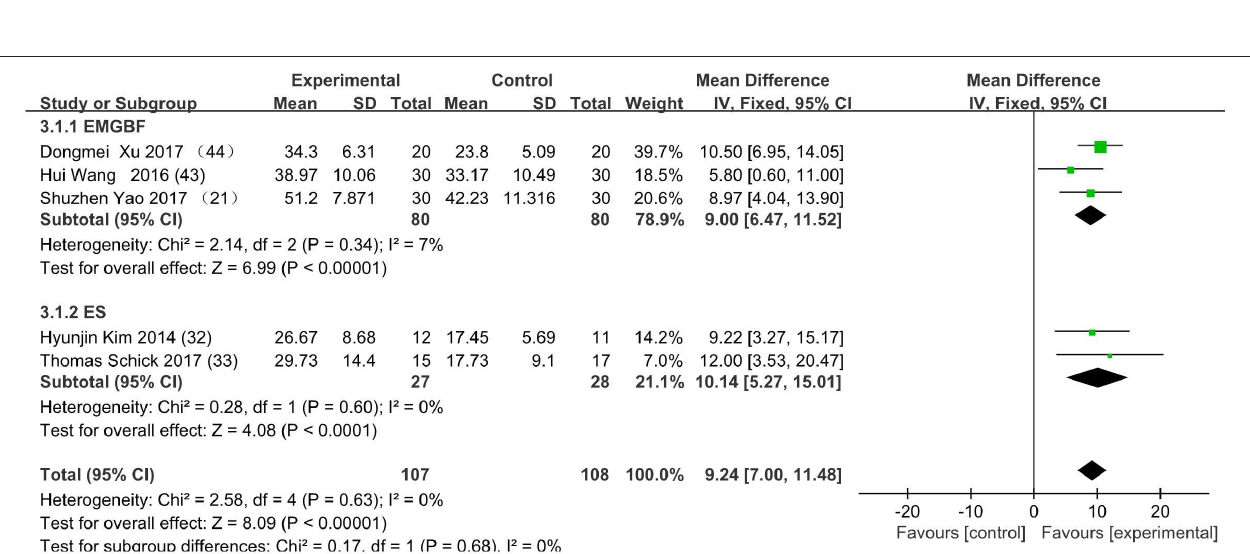
Frontiers in Neurology |